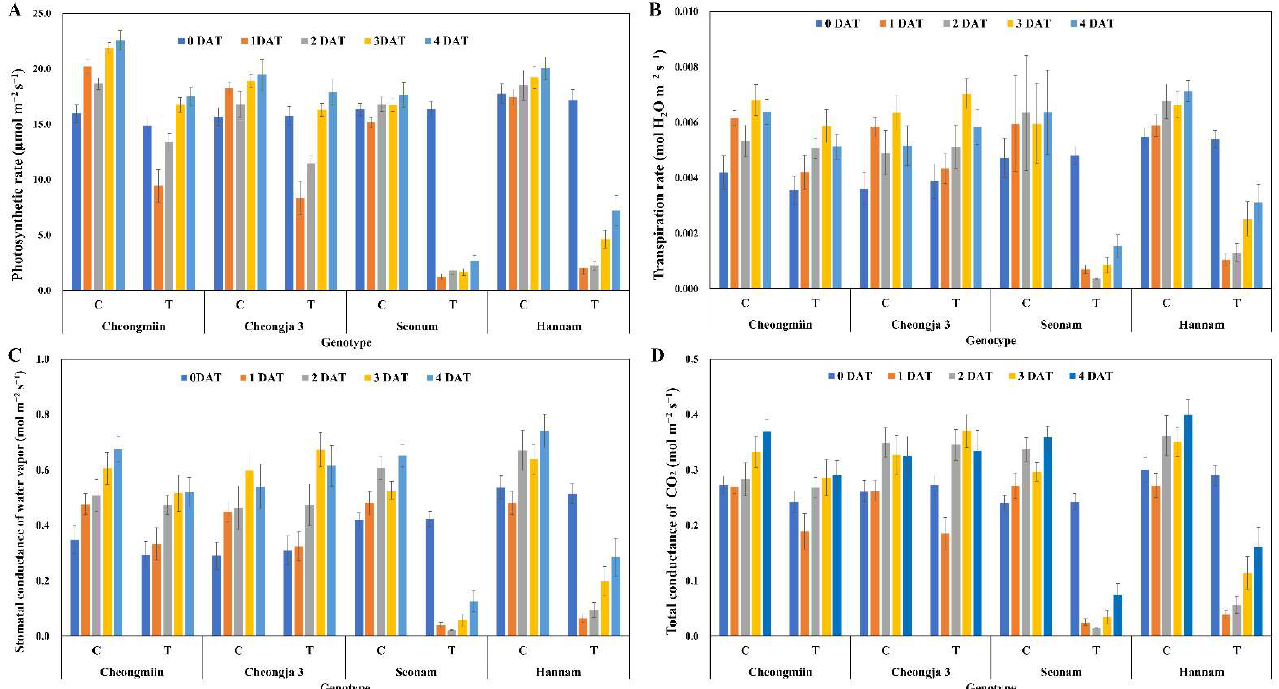
Figure 3. Leaf gas exchange parameters of bentazone-treated and control soybean plants. ( A ) Net photosynthetic rate. ( B ) Transpiration rate. ( C ) Stomatal conductance of water vapor. ( D ) Total conductance of CO 2 . “C” and “T” represent control and treatment, respectively. The 0 days after treatment (DAT) corresponds to date before treatment. Error bars indicate the standard error.